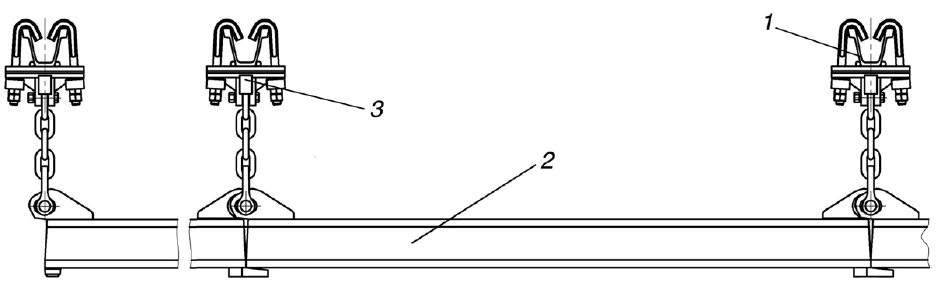
Figure 1. General view of the mine suspended monorail road: 1—support of the mine working; 2—monorail track; 3—monorail suspension.